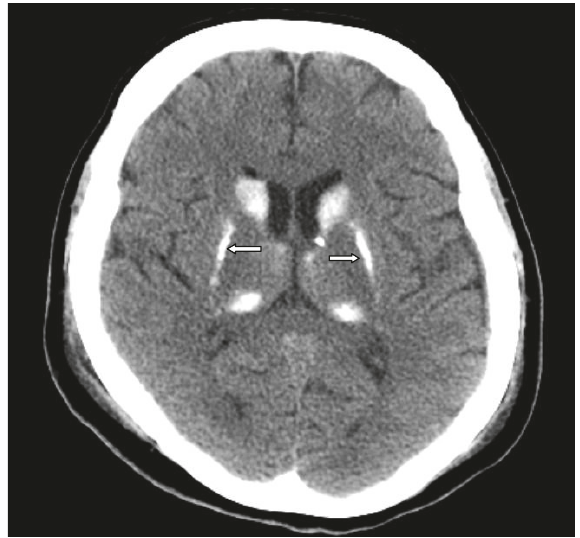
Figure 2: Bilateral symmetrical calcifications are seen in the basal ganglia of the brain